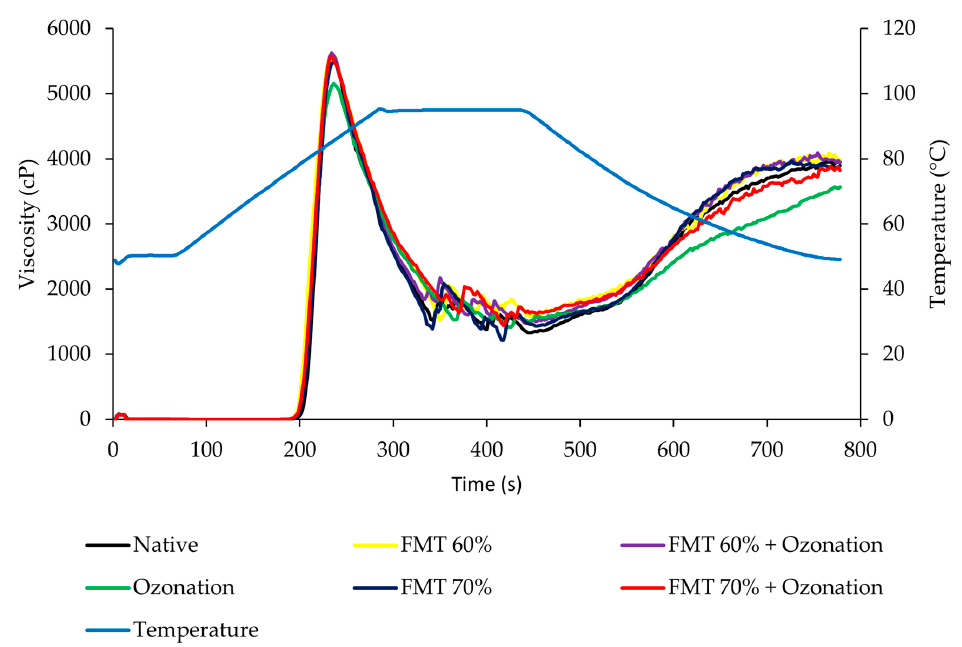
Figure 5. The visco-amylograph of native adlay starch and adlay starch modified by FMT and